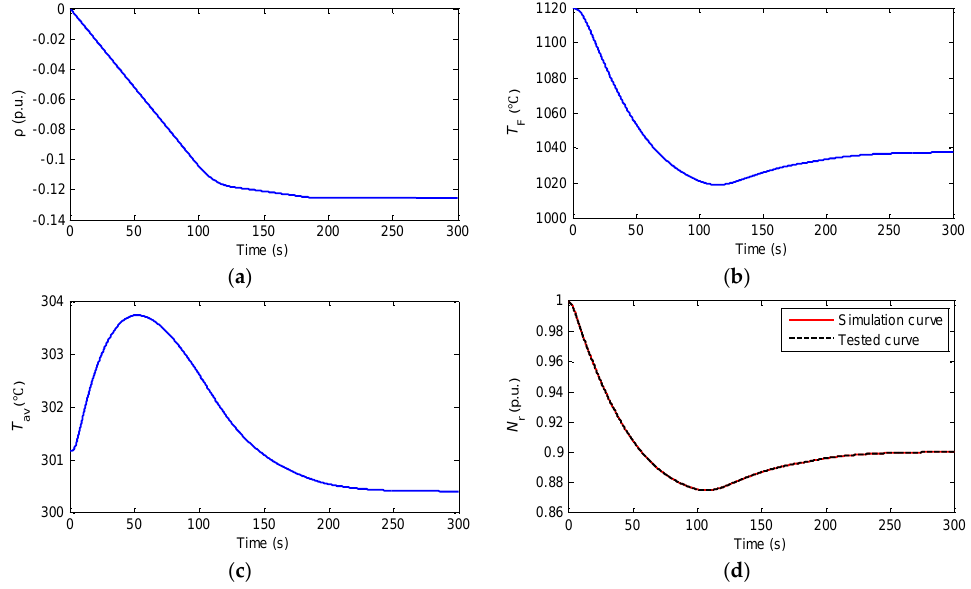
Figure 16. Comparison results of the core neutron dynamic module. ( a ) Input change of ρ ; ( b ) input change of T F ; ( c ) input change of T av ; and ( d ) output change of N r .